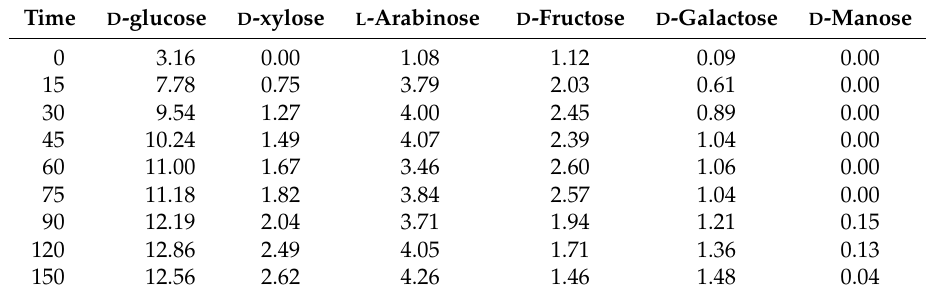
Table 5. Sugar concentrations, (kg m − 3 ), obtained after the hydrolysis in the